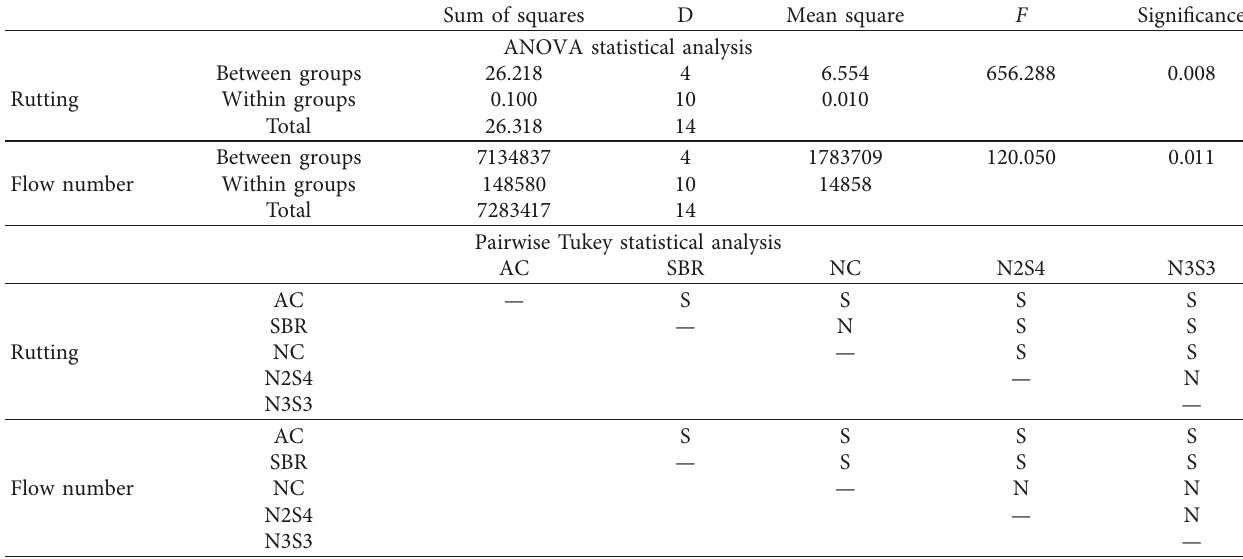
Table 5: ANOVA pairwise Tukey statistical analysis for rutting and flow number. Sum of